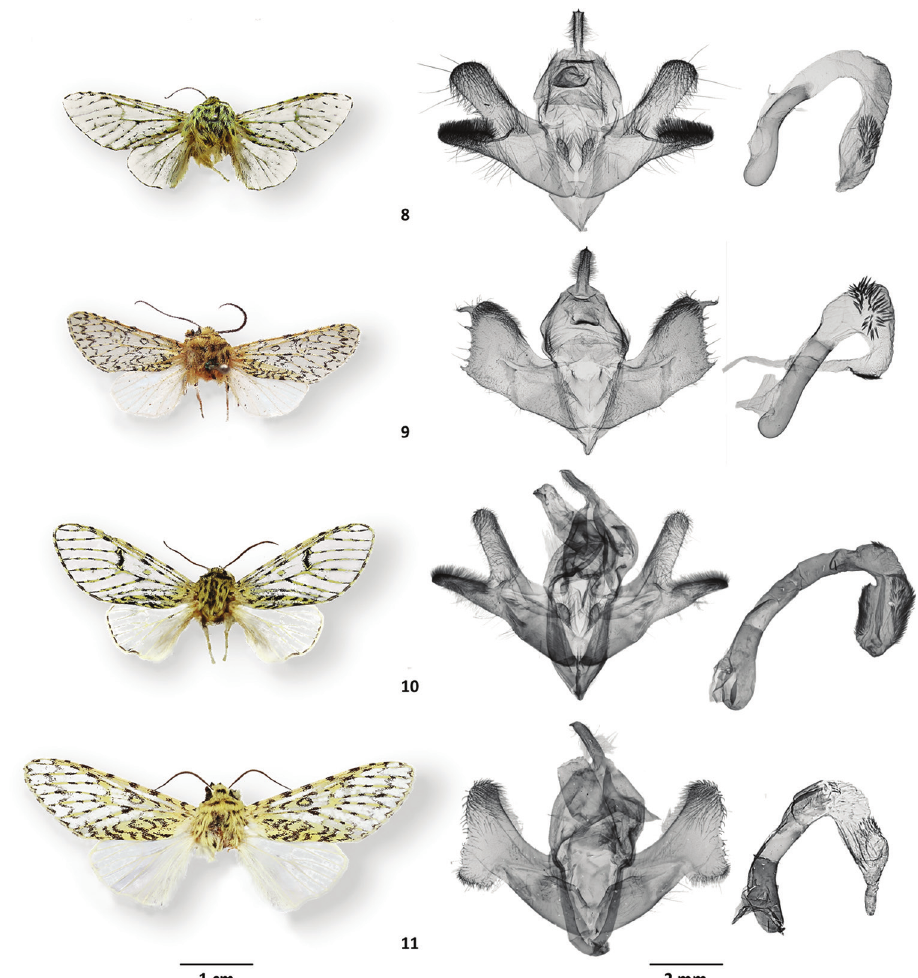
Figures 8–11. Type specimens 8 Gaujonia arbosi , lectotype, USNM, Loja, Ecuador 9 Millerana arbo- sioides , holotype, USNM, Loja, Ecuador 10 Oculicattus renifera , holotype, NHMUK, Puno, Peru 11 Ci- cadoforma vau-nigrum , holotype, NHMUK, Tovar,